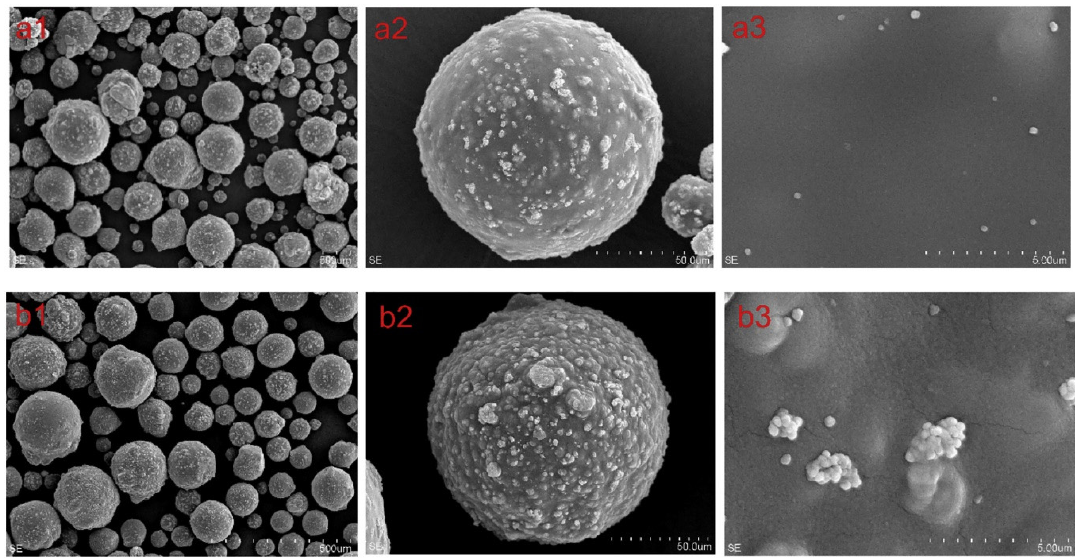
Figure 8. SEM images of ( a1 – a3 ) Fe 3 O 4 ‐ chitosan spheres and ( b1 – b3 ) Fe 3 O 4 ‐ chitosan PDAC spheres. Reprinted from Sarafaz et al. [153] with permission of Elsevier.